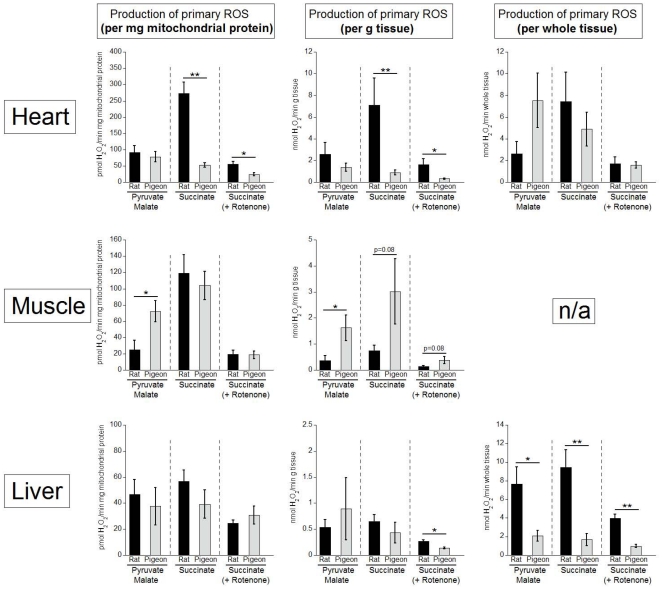
Mitochondrial production of primary reactive oxygen species (ROS).Primary ROS production was measured in rat (black bars) and pigeon (grey bars) heart, pectoral muscle and liver using pyruvate (+malate) and succinate as substrates for the respiration chain. Using succinate, ROS production was determined in the absence and presence of the complex I inhibitor rotenone. Primary ROS production is expressed in pmol H2O2/min/mg mitochondrial protein (left graphs), nmol H2O2/min/g tissue (middle graphs) and in nmol H2O2/min/whole tissue (right graphs). Shown are means ± SEM, n = 7 for rats and n = 8 for pigeons. Significant differences are highlighted with one (p<0.05) or two asterisks (p<0.01).